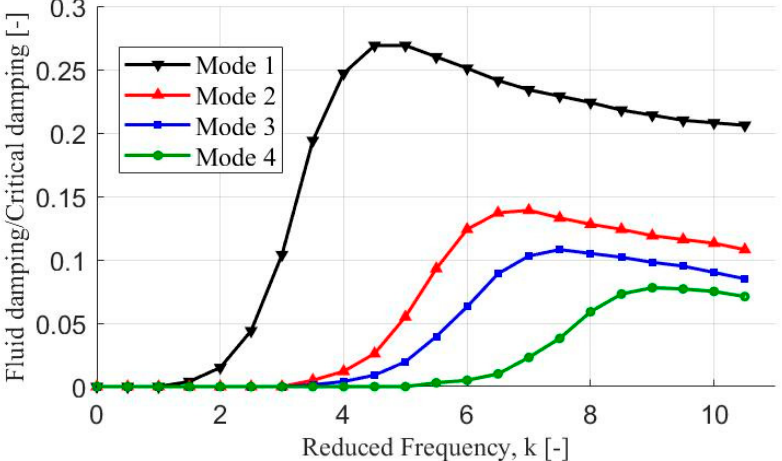
Figure 10. Fluid damping ratio as function of reduced frequency for trapezoidal simply supported plate.